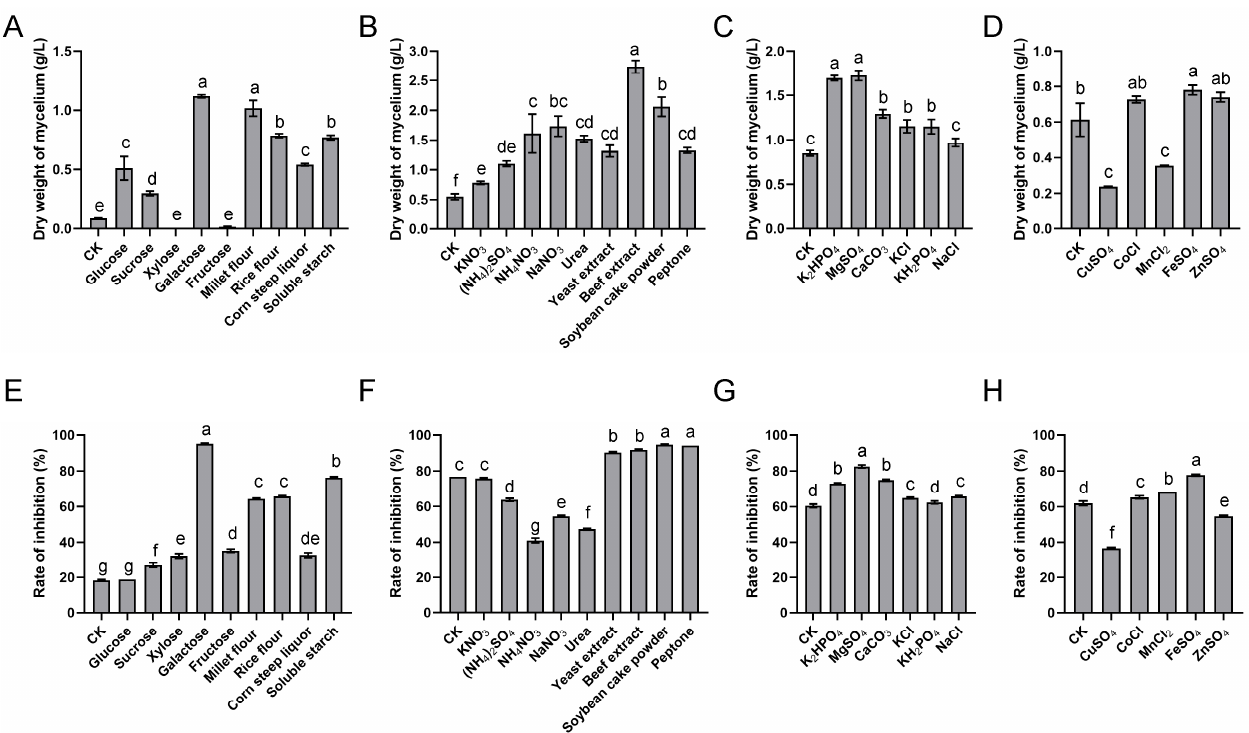
Figure 1. Effect of different nutrient sources on the biomass yield and antifungal metabolites production of S. alfalfae XN-04. ( A , E ) Effect of carbon sources. ( B , F ) Effect of nitrogen sources. ( C , G ) Effect of mineral salts. ( D , H ) Effect of trace elements. The dry weight of mycelium was used as indication of biomass, and the rate of inhibition was used as indication of antifungal metabolites production. Bars represent the SD of three replicates. Different lowercase letters indicate a significant difference at p < 0.05 level by Duncan’ s new multiple range test.